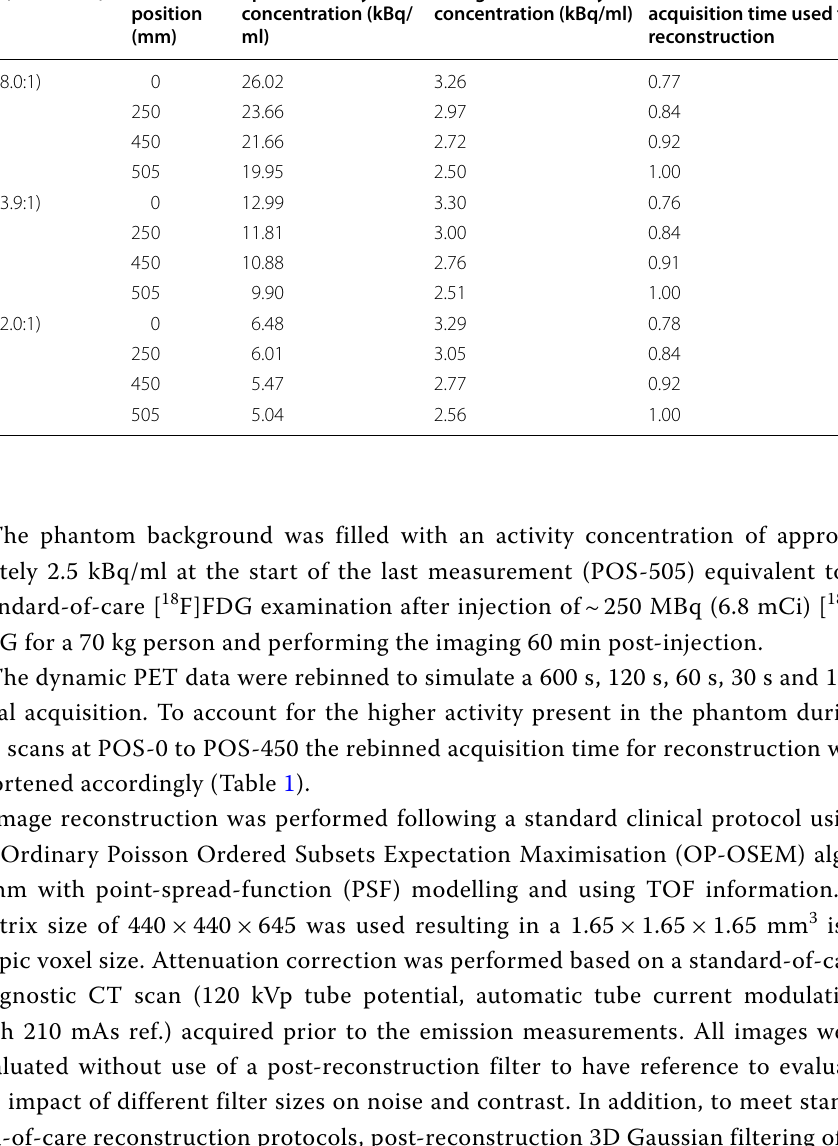
Table 1 Activity concentrations and SBRs for all phantom acquisitions as determined with the dose calibrator SBR (calculated) Axial